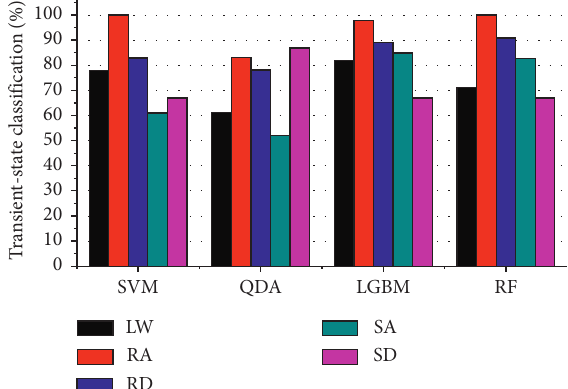
Figure 7: Transient-state recognition at preswing